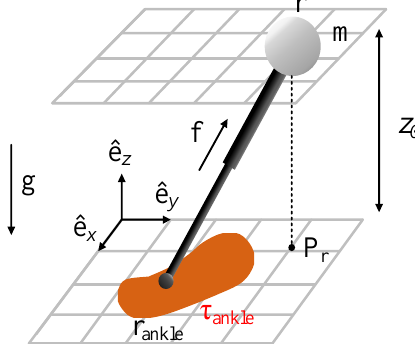
Figure 1. LIPM with finite-sized feet.